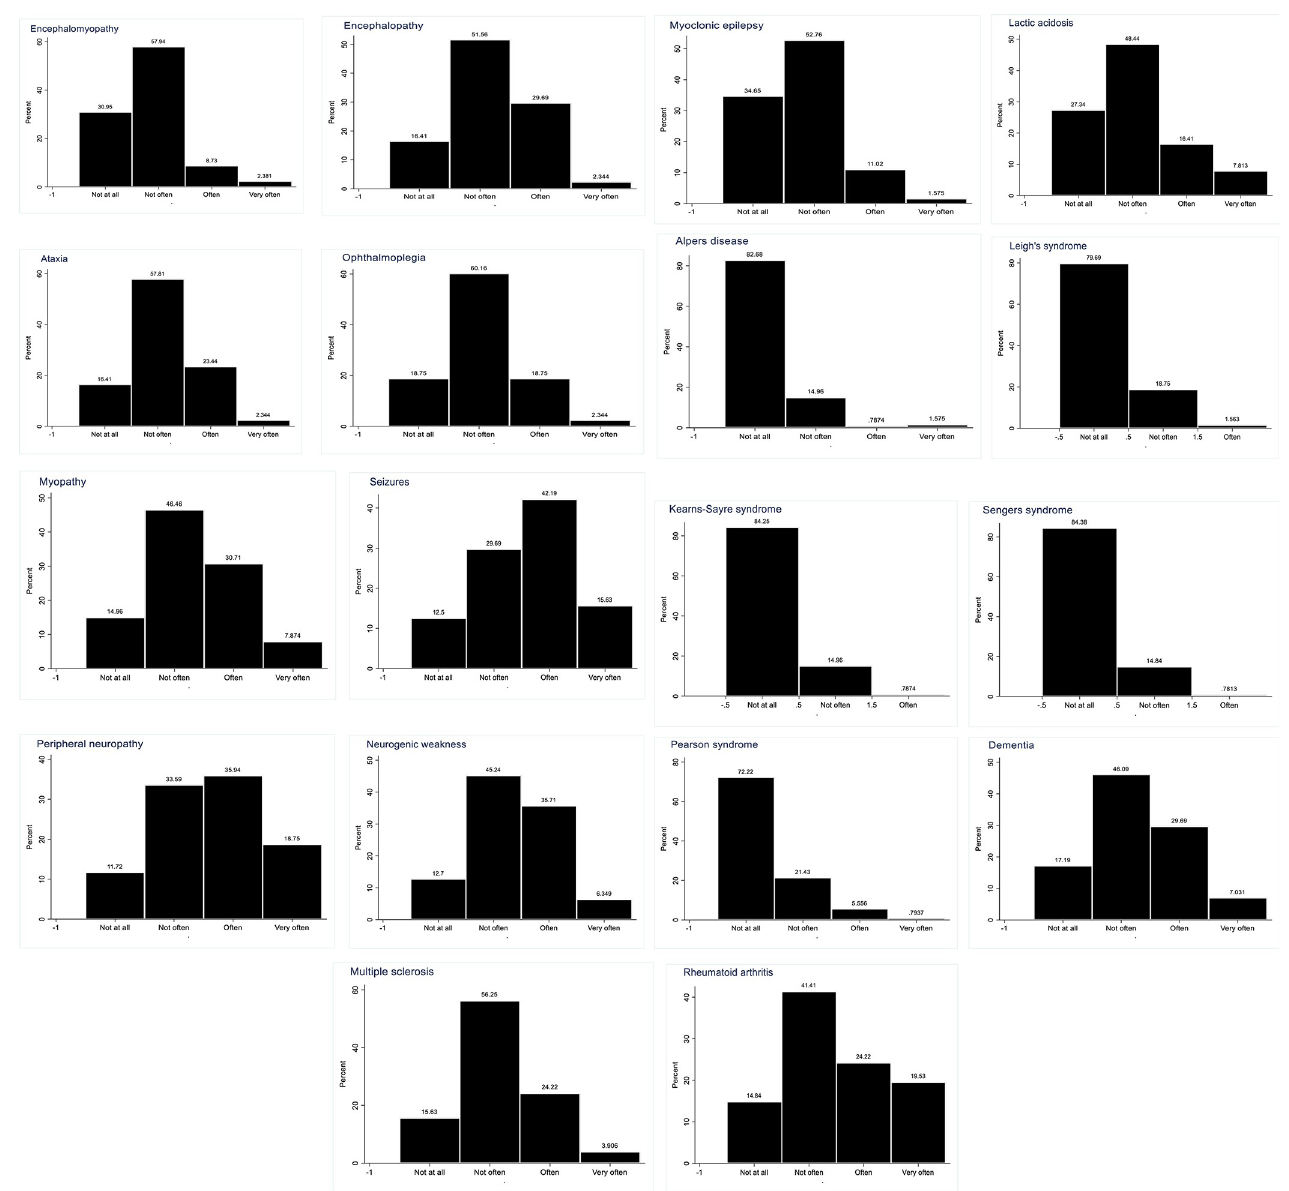
Fig 2. Frequency of encountering patients with specific mitochondrial-related